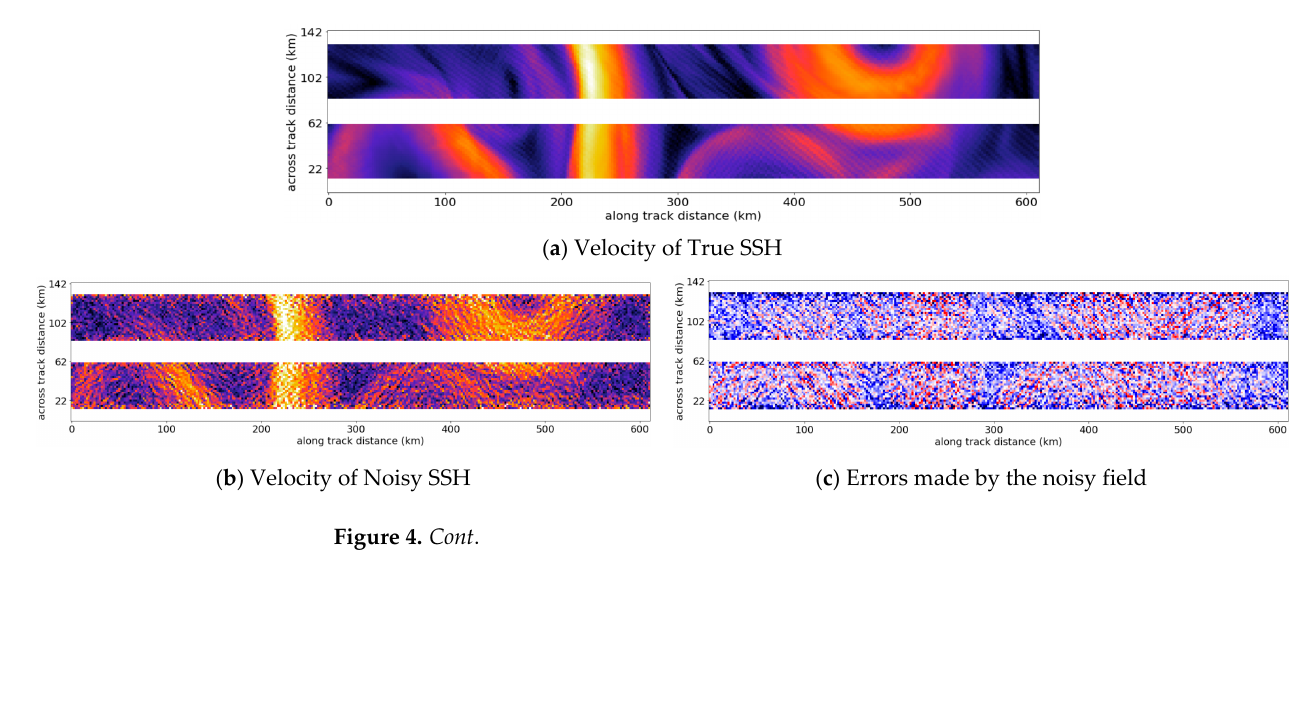
Figure 3. ( a ) True SSH, ( b ) Noisy SSH, ( c ) the KaRIn noise applied, ( d ) SSH denoised by the U-Net and ( e ) its error (Pass 496, cycle 17 located in the Gulf Stream).